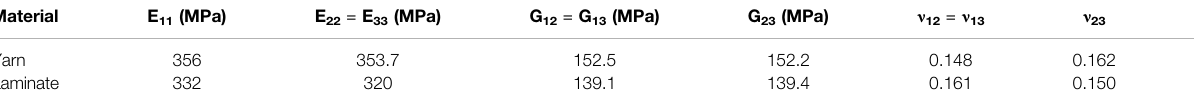
TABLE 1 | Input mechanical properties for yarn and laminate, calculated from micro-UD model (Feng et al., 2020). Material